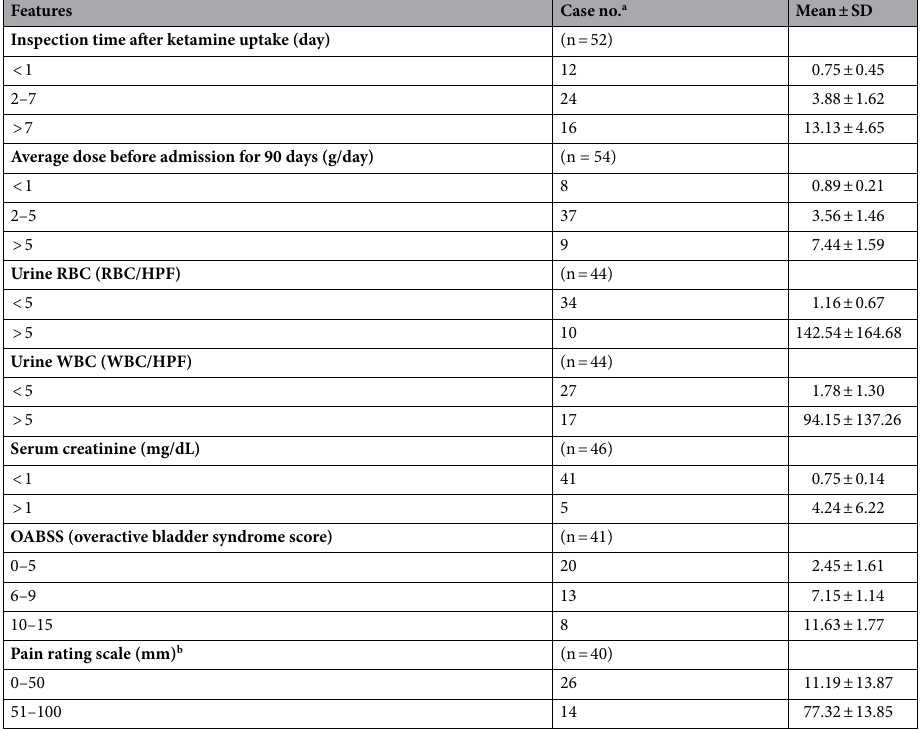
Table 2. Clinicopathological features of ketamine abusers enrolled in this study. a Data from 2 to 16 cases of KA are not available for each feature. b A person rates his/her pain on a scale of 0 to 100 nm. Zero means “no pain”, and 100 means “the worst possible